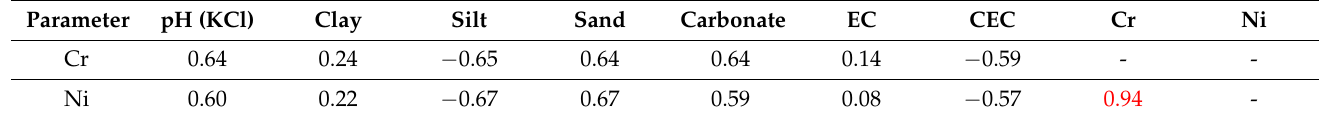
Table 3. Correlation analysis results (statistically significant marked red, α =